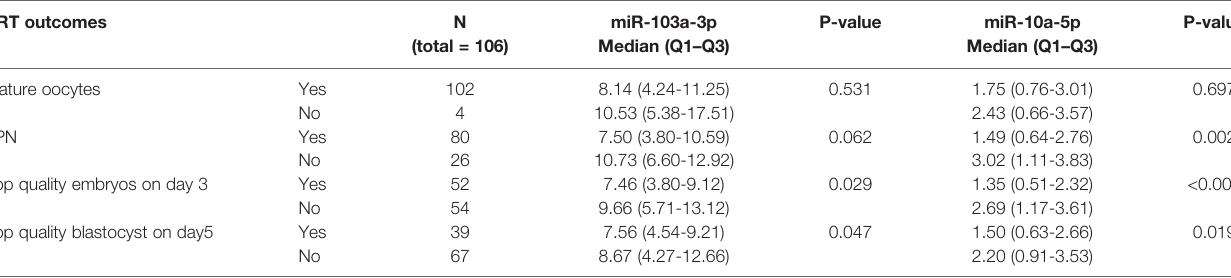
TABLE 2 | Correlation between miR-103a-3p or miR-10a-5p expression in FF and their corresponding oocyte developmental statues during IVF treatment. ART outcomes